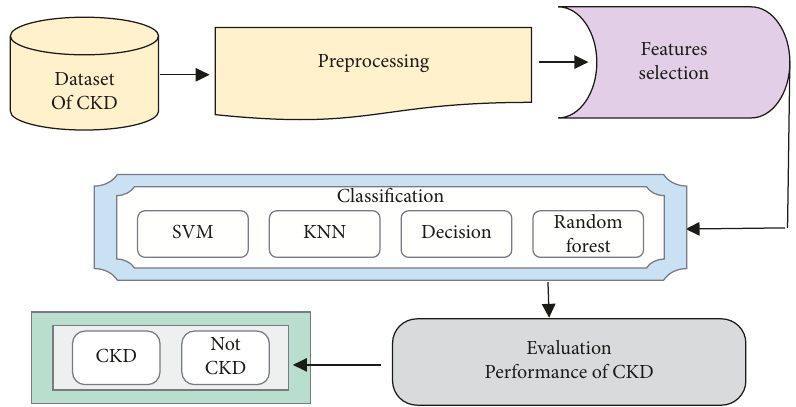
Figure 2: Role of ML algorithm for CKD detection [22].